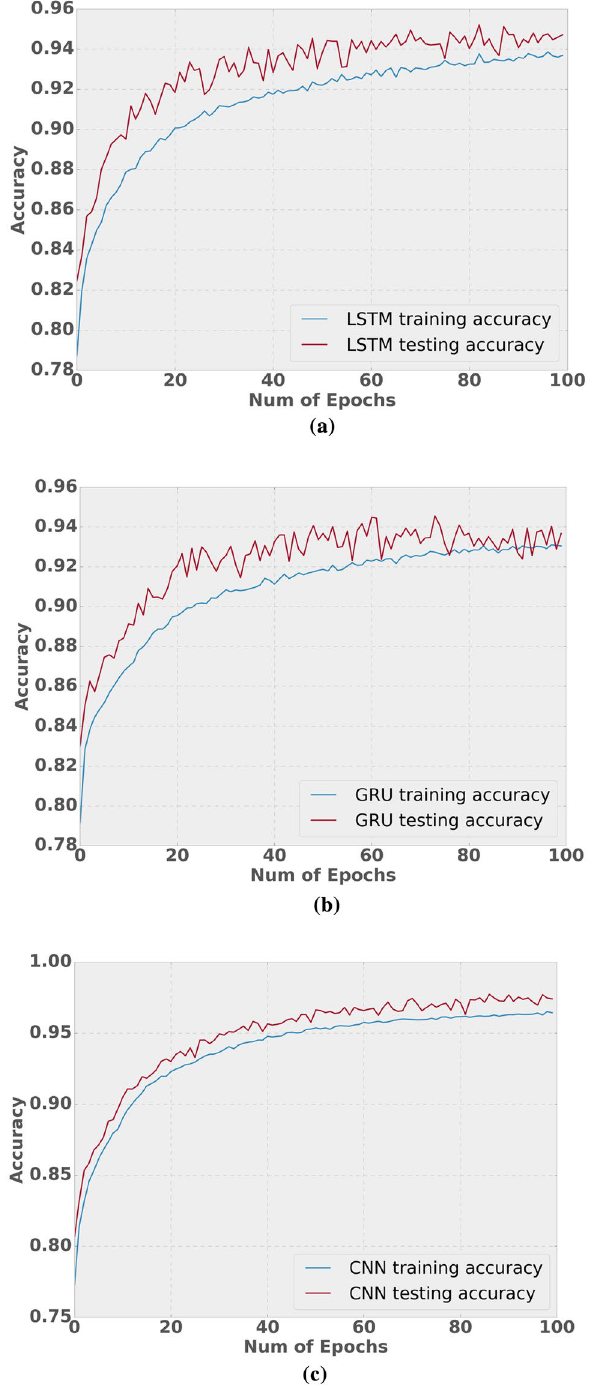
Fig. 11 a Accuracy curves for LSTM architectures calculated using Eq. (2). b Accuracy curves for GRU architectures calculated using Eq. (2). c Accuracy curves for CNN architectures calculated using Eq. (2)